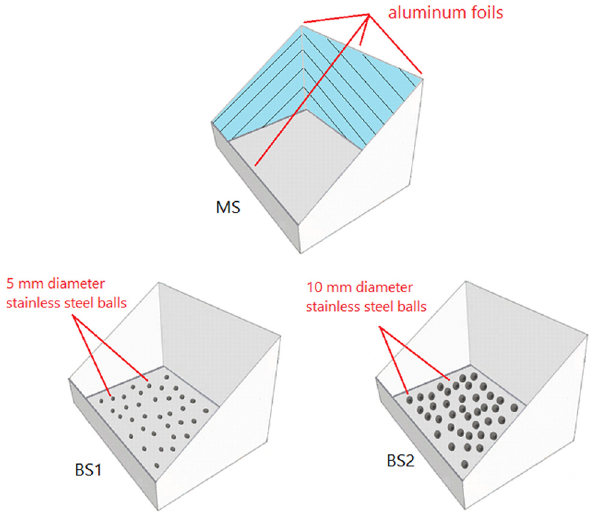
Figure 3: Line diagrams for modi fi cation